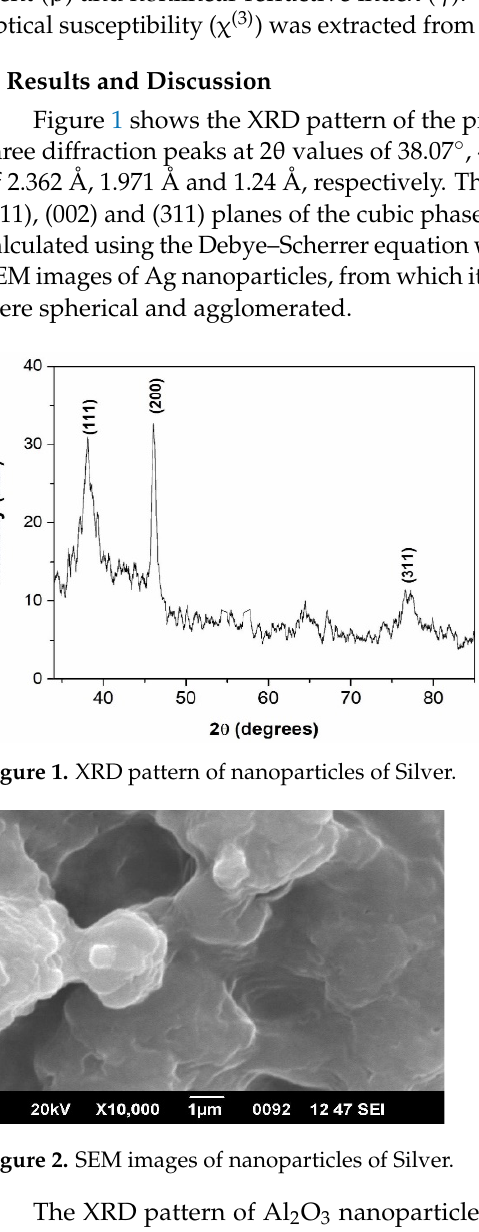
Figure 3. XRD pattern of Al 2 O 3 nanoparticles. Figure 4. SEM images of Al 2 O 3 nanoparticles. The UV–visible absorption spectrum of the synthesized nanoparticles is shown in Figure 5. The spectrum exhibits a broad peak around 410 nm. Noble metal nanoparticles